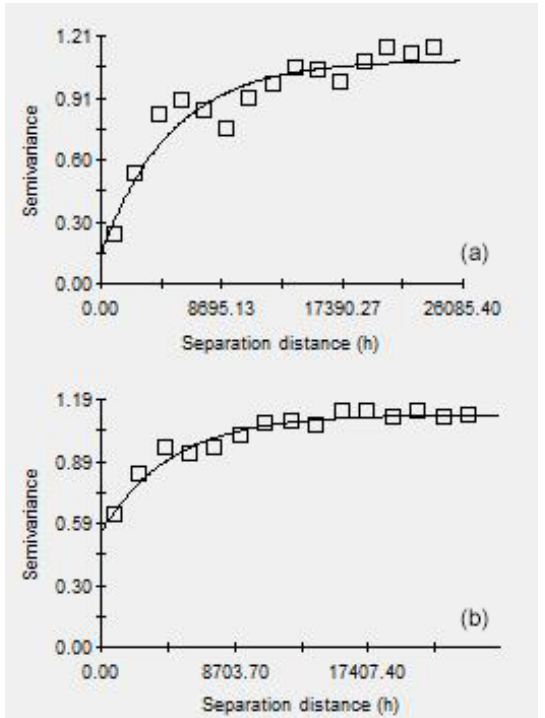
Figure 4. A fitted curve of the semi-variogram of (a) the vertical displacement rates and (b) the East-West displacement